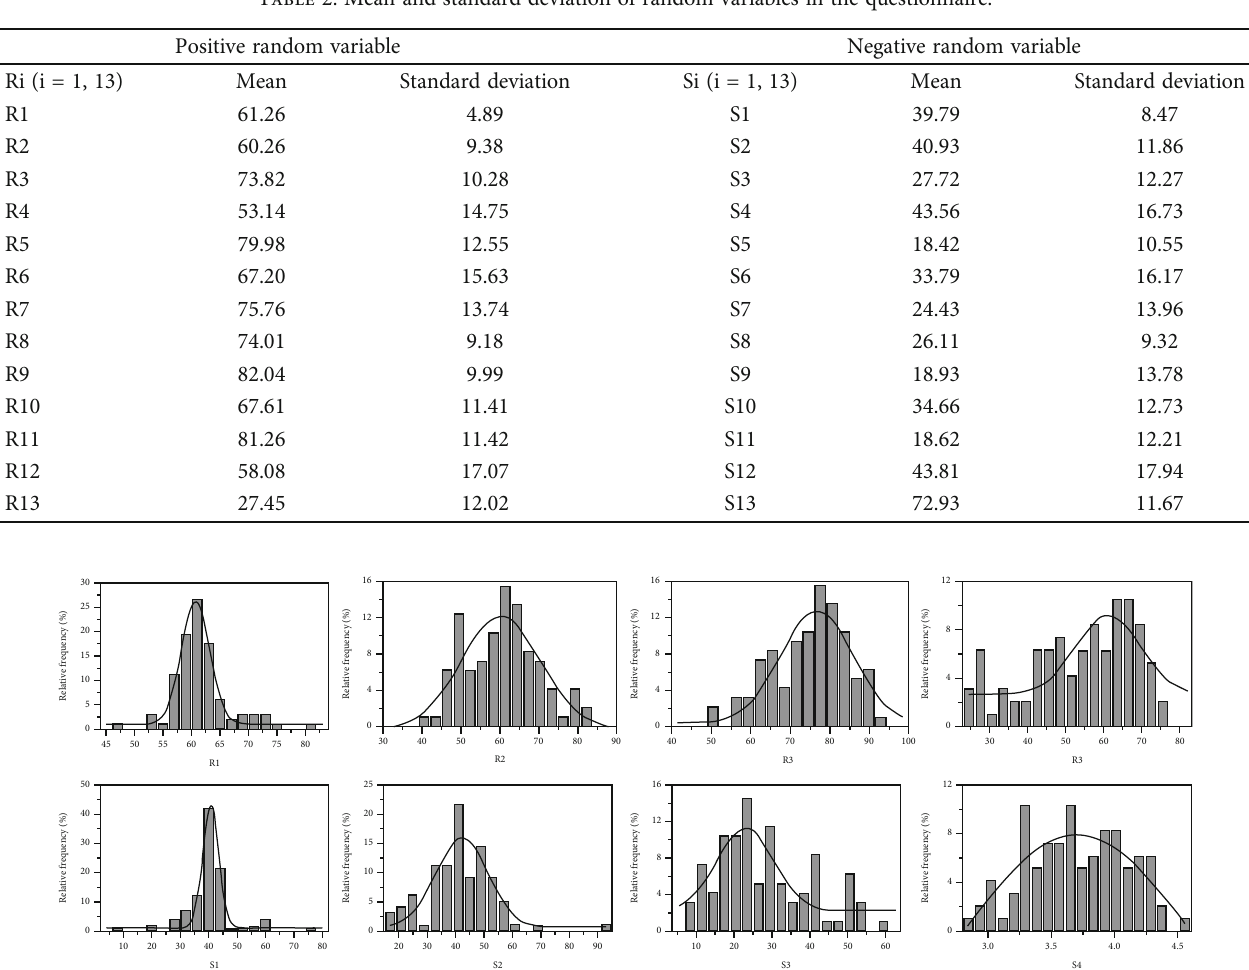
Table 2: Mean and standard deviation of random variables in the questionnaire.